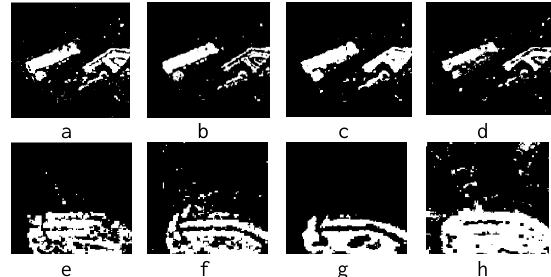
Figure 5. Output change map in CA algorithm for Data 1